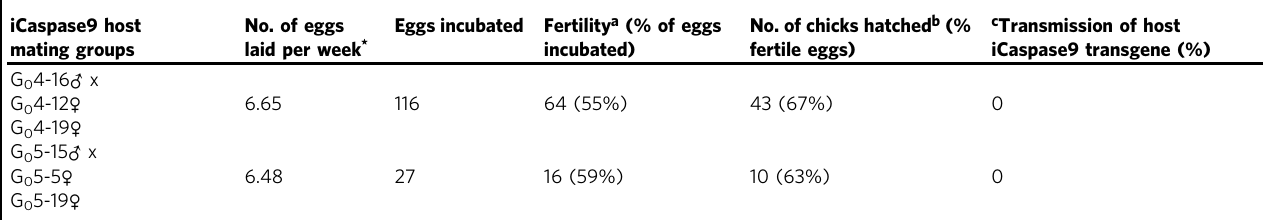
Table 2 Germline transmission rates from surrogate hosts injected with donor KRT75 -edited ♀ LSX PGCs and wild-type ♂ LSX